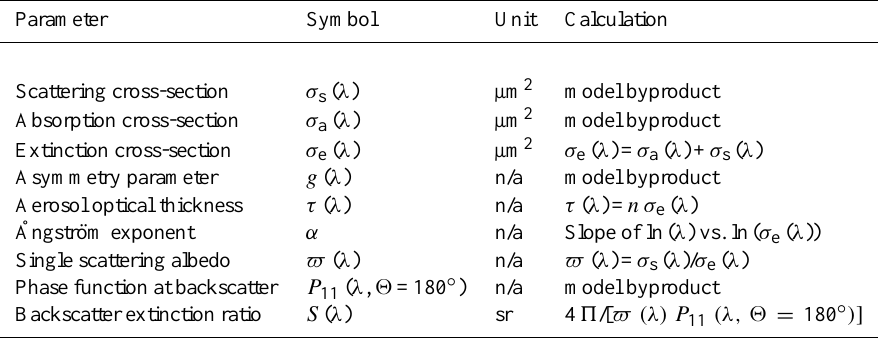
Table 2. Derived aerosol parameters. λ is wavelength. Parameter